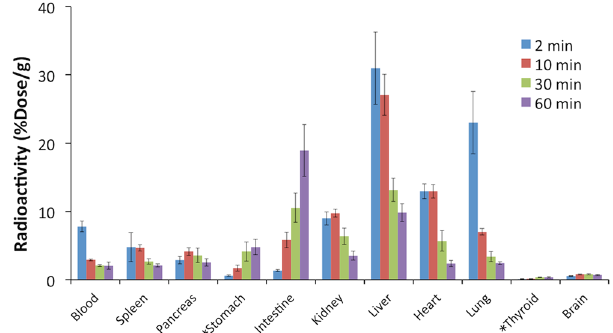
Figure 5. Biodistribution of radioactivity after injection of [ 125 I] 2 into mice ( * expressed as %Dose).